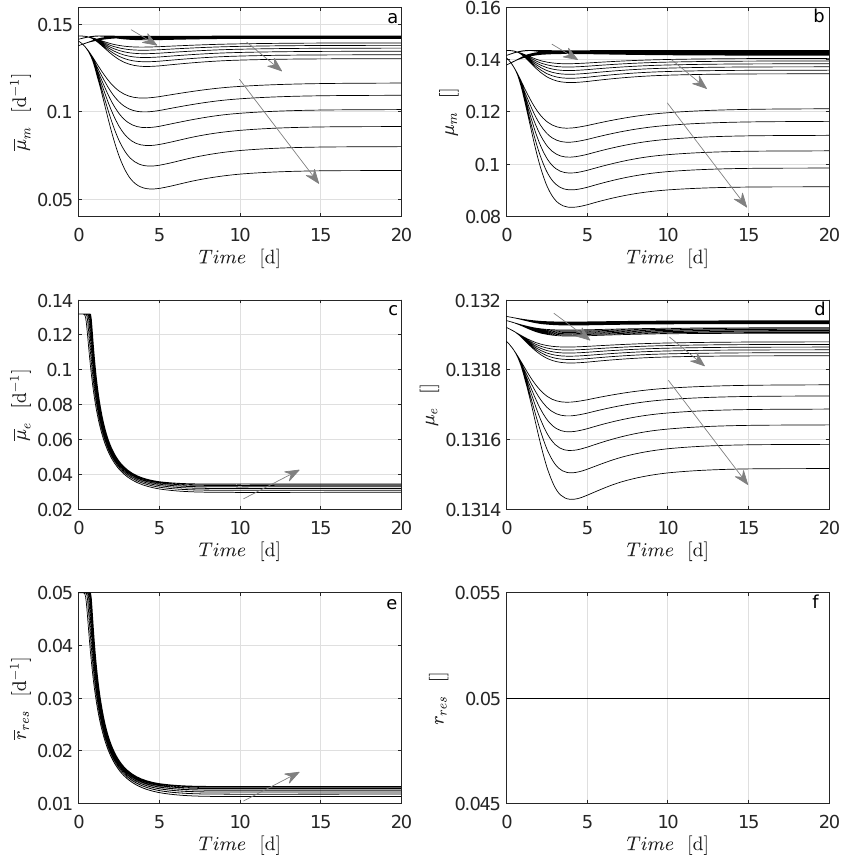
Figure 3. Numerical solution for the MEC model in (1)–(13) under operating conditions in Table 4. Average reaction rates for ( a ) exoelectrogenic microorganisms (Equation (4)), ( c ) methanogenic microorganisms (Equation (3)), and ( e ) respiration processes (Equation (5)). Reaction rates into the bulk for ( b ) exoelectrogenic microorganisms (Equation (7)), ( d ) methanogenic microorganisms (Equation (6)), and ( f ) respiration processes (Equation (8)). Arrows indicate the direction of increased applied